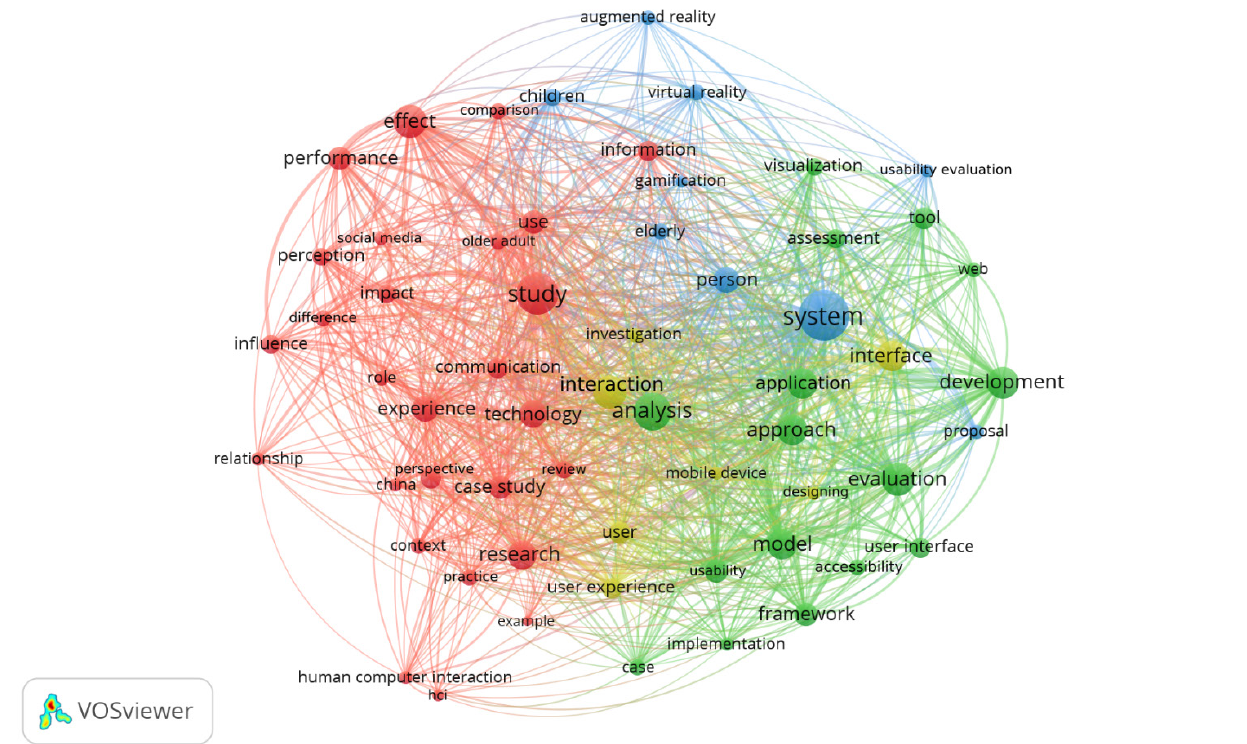
Figure 4. Correlation graph of the n2 (59) most recurring terms of